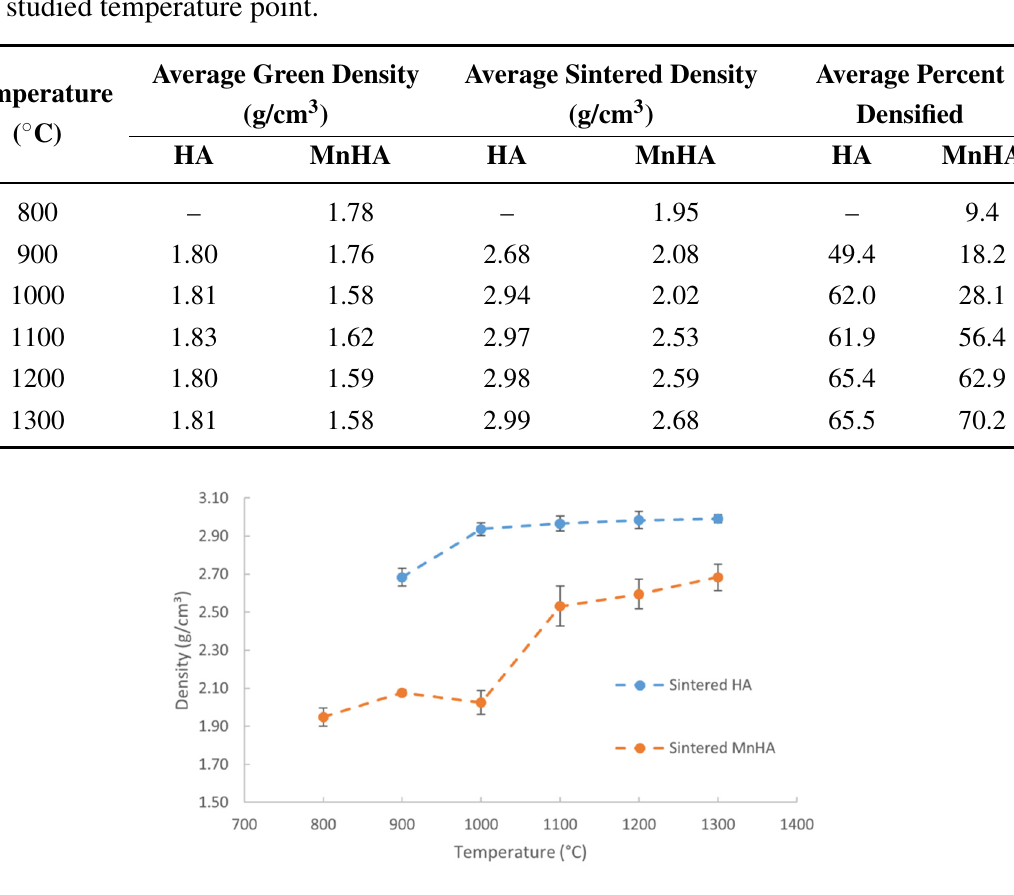
Table 1. Average density values of green and sintered bodies and percent densification for each studied temperature point.